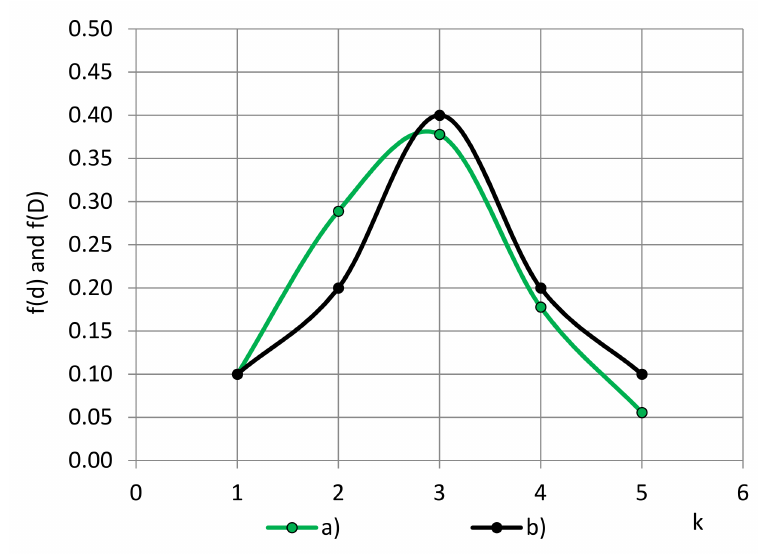
Figure 10. PFDs of diameters of (a) circles—f(d) and (b)